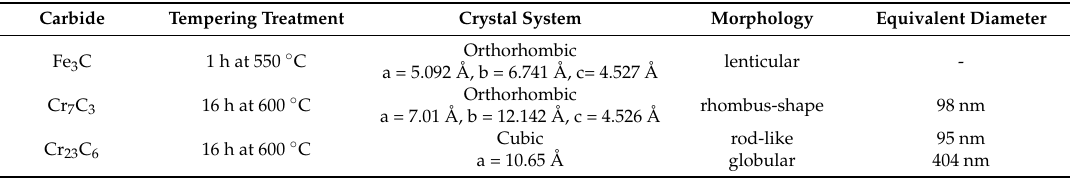
Table 2. Crystal structure, morphology and size of identified carbides in the tempered medium-carbon low-alloy